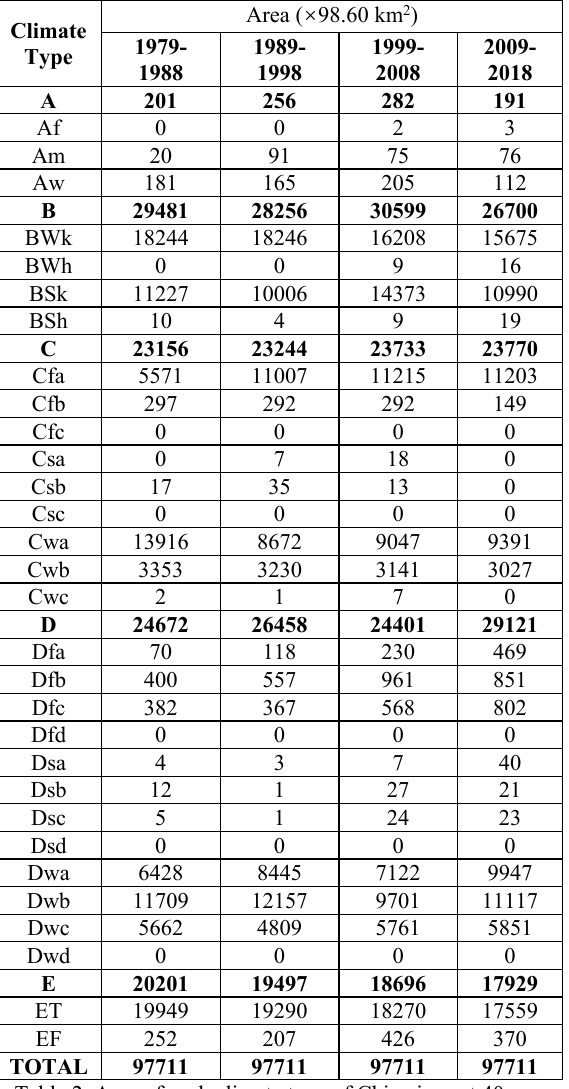
Table 2. Area of each climate type of China in past 40 years -5.7 × 10 4 km 2 /10a, which is accompanied by an upward trend of Dwc climate (Fig. 1). The trend from polar climate to cold climate indicates that the Tibetan Plateau becomes warming these years, which is consistent with Wu et al.’s findings